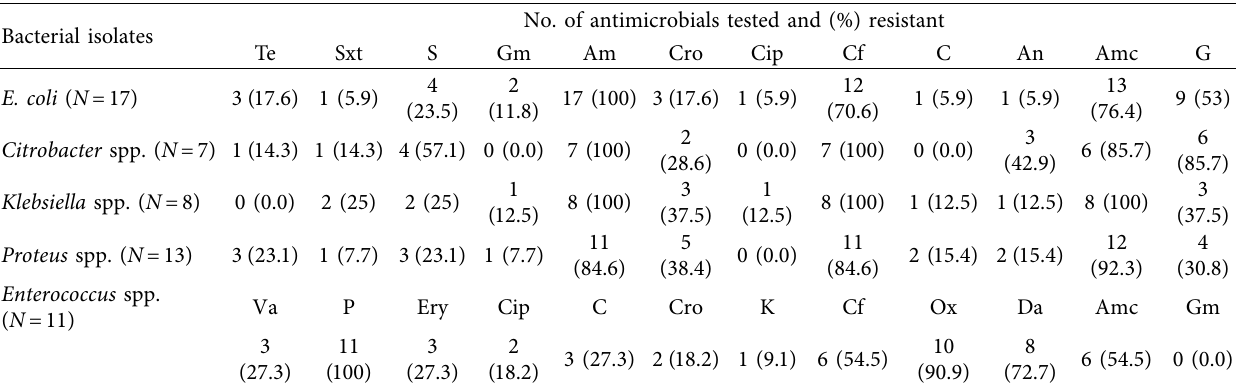
Table 3: Antimicrobial susceptibility of bacteria isolated from pregnant women with ASBU attending antenatal care services in Addis Ababa, Ethiopia ( N =56).